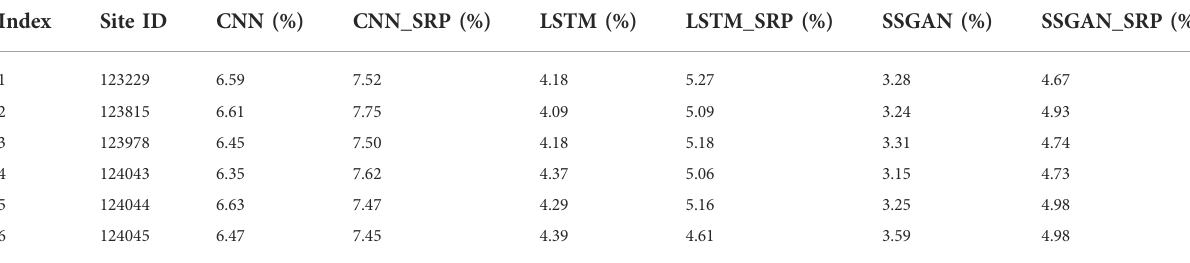
TABLE 4 MAPE results of short-term wind power forecasting on TLHB.